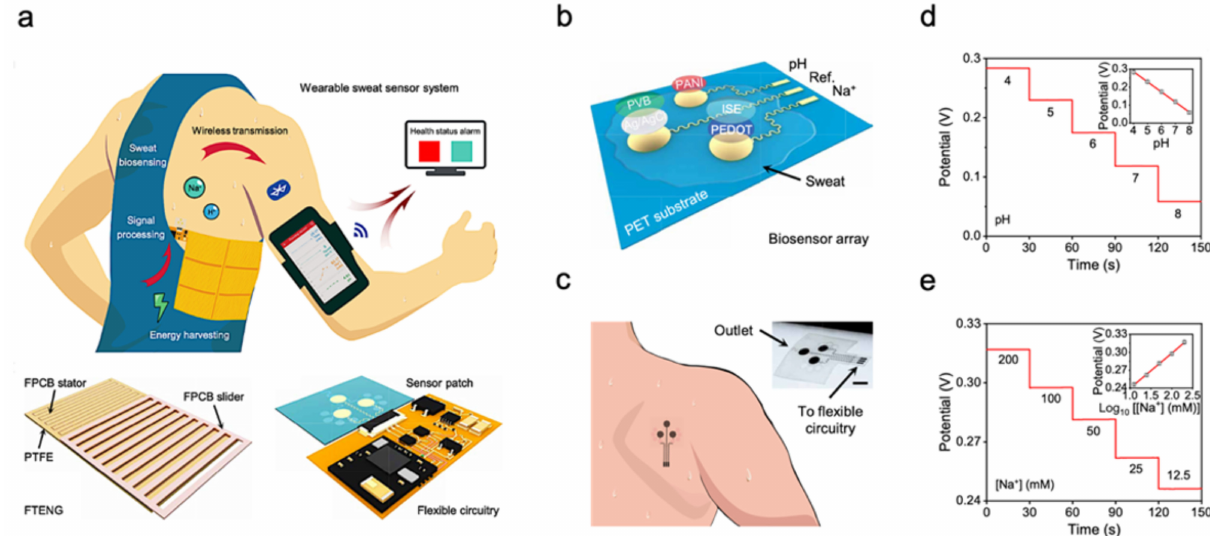
Figure 3. Sweat-based sensors for continuous health monitoring. ( a ) Describes the working of the device and shows the developed FTENG to power device. ( b ) Schematic of the sensor array. ( c ) Schematic of microfluidic sensor patch. ( d , e ) Open-circuit potential responses of the pH sensor in standard Mcllvaine’s buffer solutions ( d ) and a sodium ion sensor in NaCl solutions ( e ). Reproduced with permission from ref. [107], Copyright from 2020, the American Association for the Advancement of